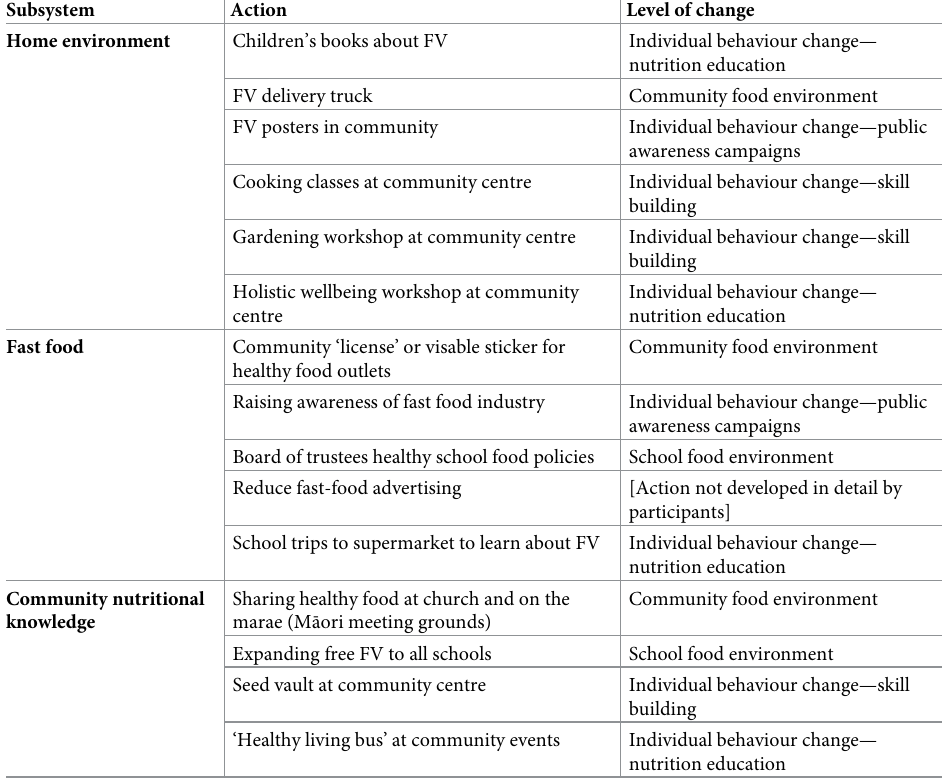
Table 3. Actions proposed by workshop participants and their level of change.